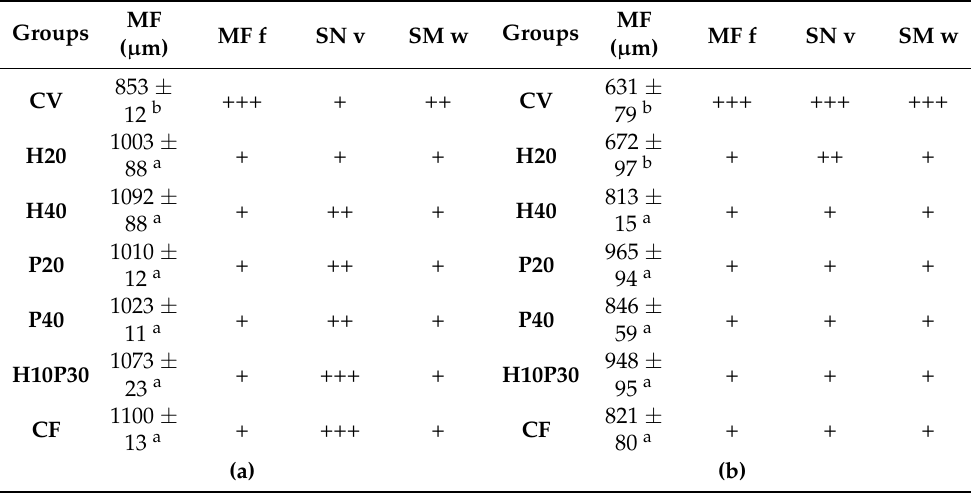
Table 5. Mucosal fold morphometric evaluation and histological index scores in the medium ( a ) and distal intestine ( b ) from fish fed experimental diets.